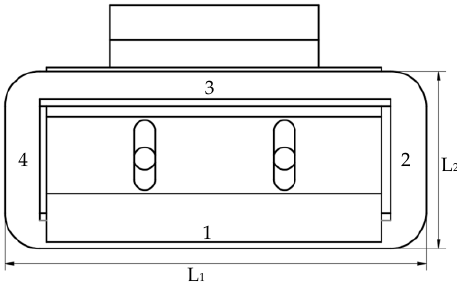
Figure 6. Model of the Lorentz coils.